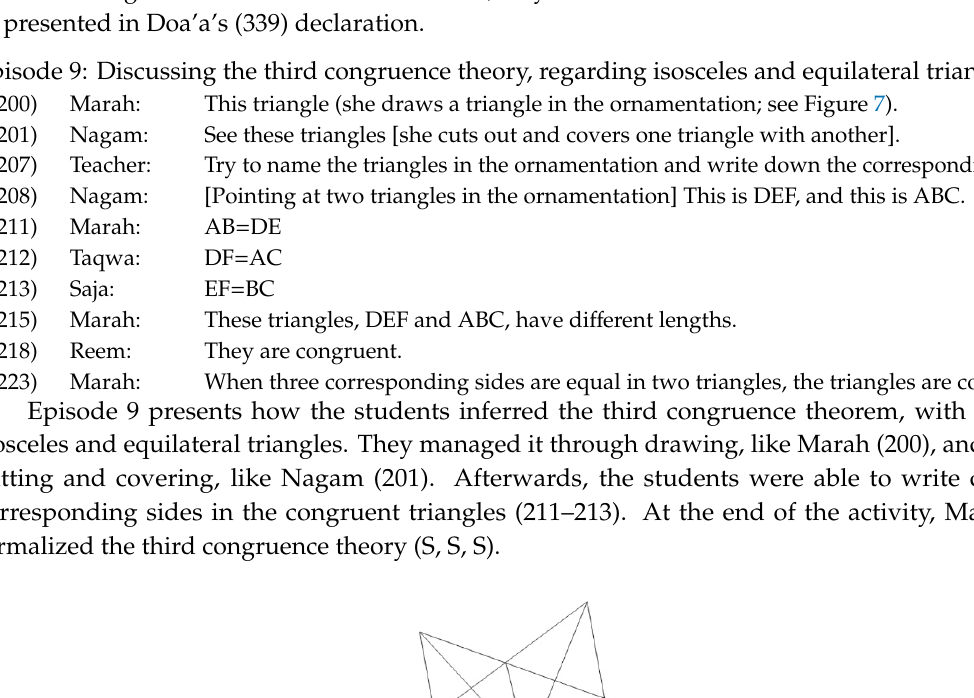
Figure 8. Figure of Task 1. Task 2: In Figure 9, given: ∢ C = ∢ A E is the middle of AC Prove that E is the midpoint of BD Figure 9. Figure of Task 2.